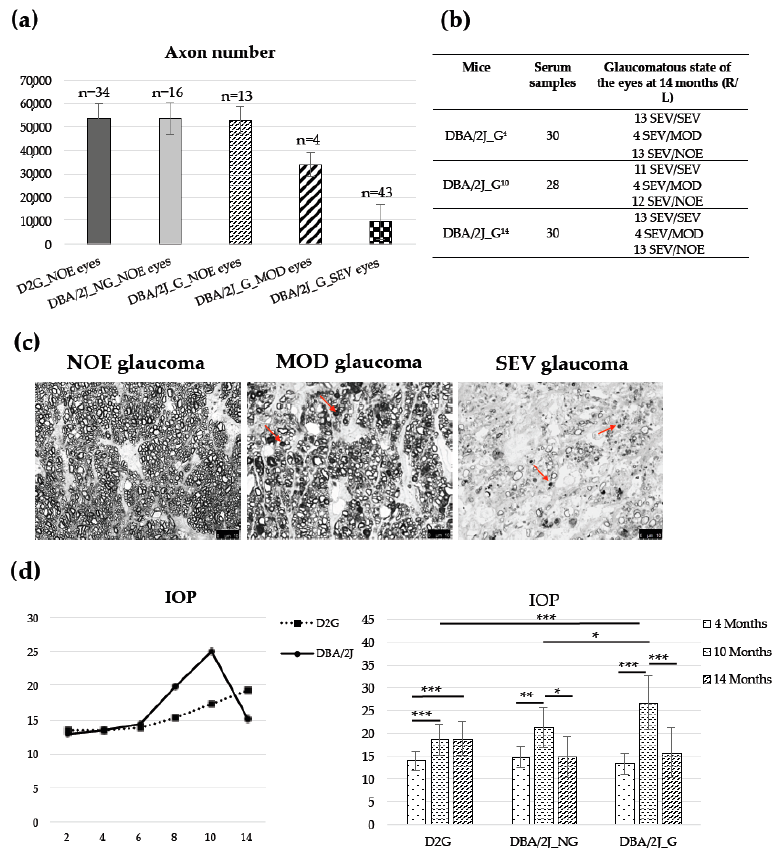
Figure 3. ( a ) Axon number in the optic nerves of D2G and DBA/2J mice at 14 months old. NOE, no or early glaucoma; MOD, moderate glaucoma; and SEV, severe glaucoma. The average number of axons and the standard deviation are represented (n, number of eyes). ( b ) Serum samples from DBA/2J_G mice at 4, 10 and 14 months and glaucomatous state of the eyes of these mice at 14 months. ( c ) Representative images of optic nerve damage levels in DBA/2J mice 14 months old: NOE glaucoma, few or no damaged axons in the optic nerve; moderate glaucoma, clear presence of damaged axons and axon loss, and severe glaucoma, massive axon loss. Arrows show damaged axons that stain darkly with PPD. Images were taken from semi-thin sections of the retro-orbital region of the optic nerve stained with PPD Scale bar 10 μ M. ( d ) IOP evolution with age. Left, IOP evolution in the D2G and DBA/2J colonies. Right, IOP values in the mice D2G, DBA/2J_NG, and DBA/2J_G used for serum extraction at 4, 10, and 14 months old. *, p -value < 0.05; **, p -value < 0.01; ***, p -value <